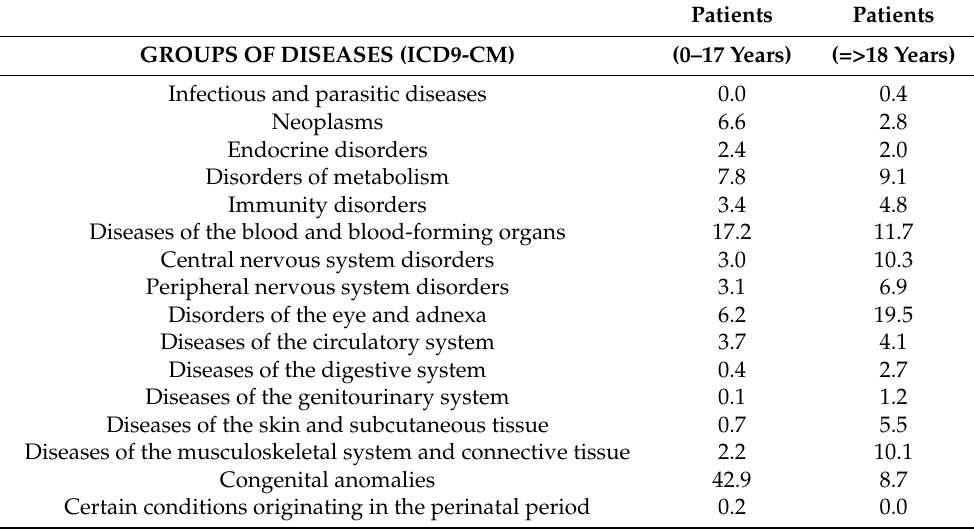
Table 2. Percentage distribution per nosological group (ICD-CM) of pediatric and adult RD patients.